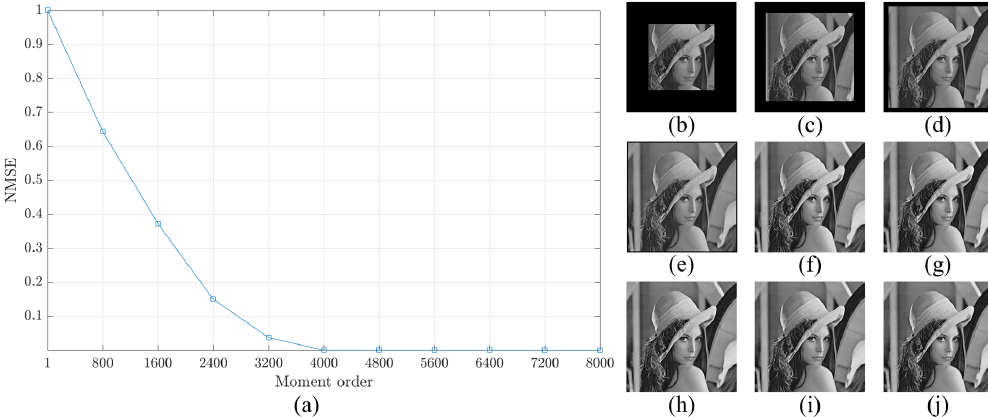
Figure 12. Construction analysis for the proposed method using Lena image. ( a ) NMSE, image reconstructed using number of moment equal to ( b ) 800, ( c ) 1600, ( d ) 2400, ( e ) 3200, ( f ) 4000, ( g ) 4800, ( h ) 5600, ( i ) 6400, and ( j )